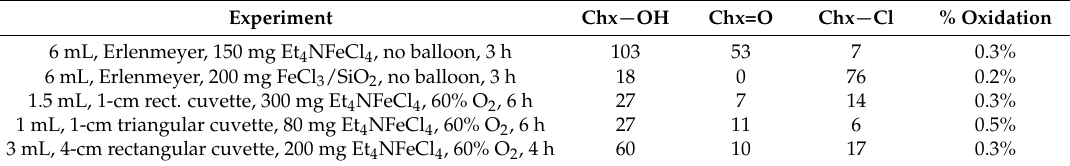
Table 10. Product yields ( µ mol) after irradiation of cyclohexane (0.5% acetic acid) in sunlight a . Experiment Chx − OH Chx=O Chx − Cl % Oxidation